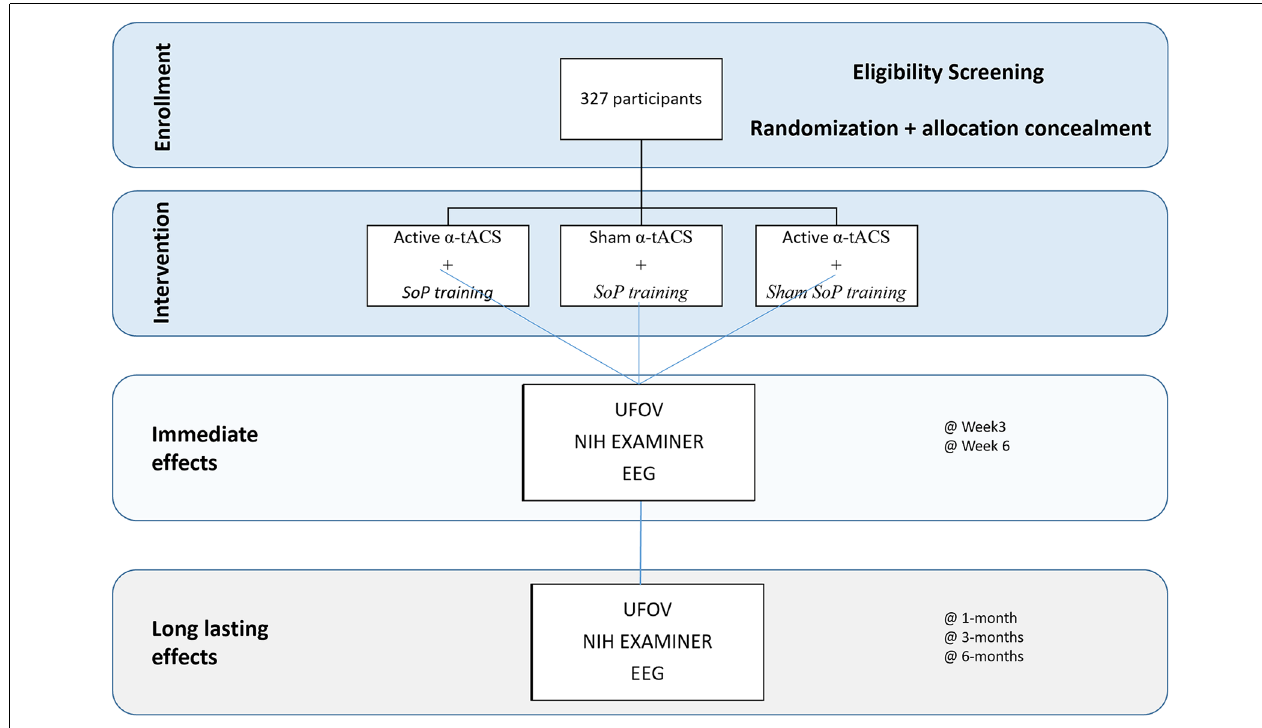
FIGURE 1 | Schematic representation of the protocol.